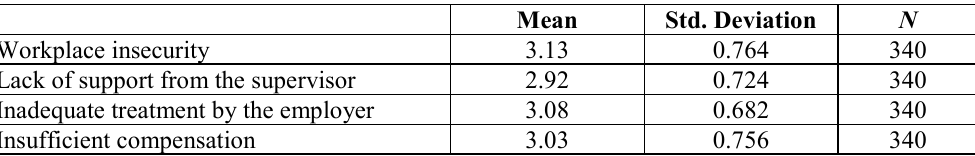
Table 5. Occupational